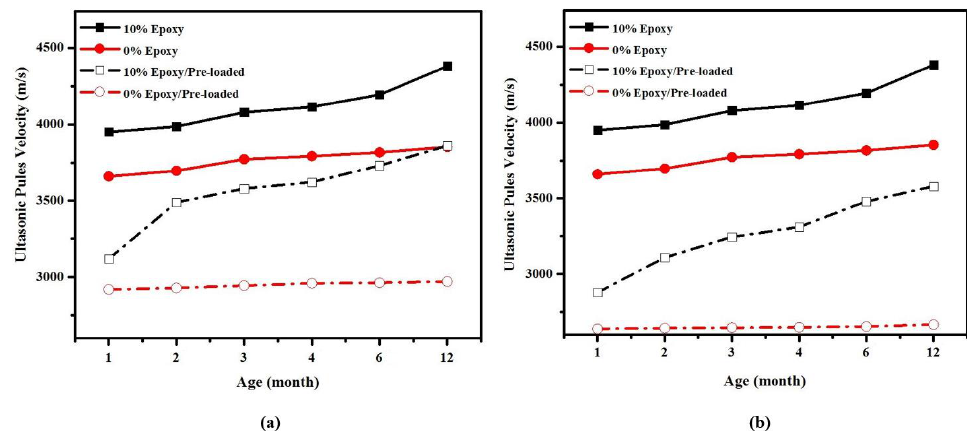
Figure 13. Self-healing efficiency of epoxy resin on UPV reading of pre-loaded specimens ( a ) 50% ( b ) 80%.